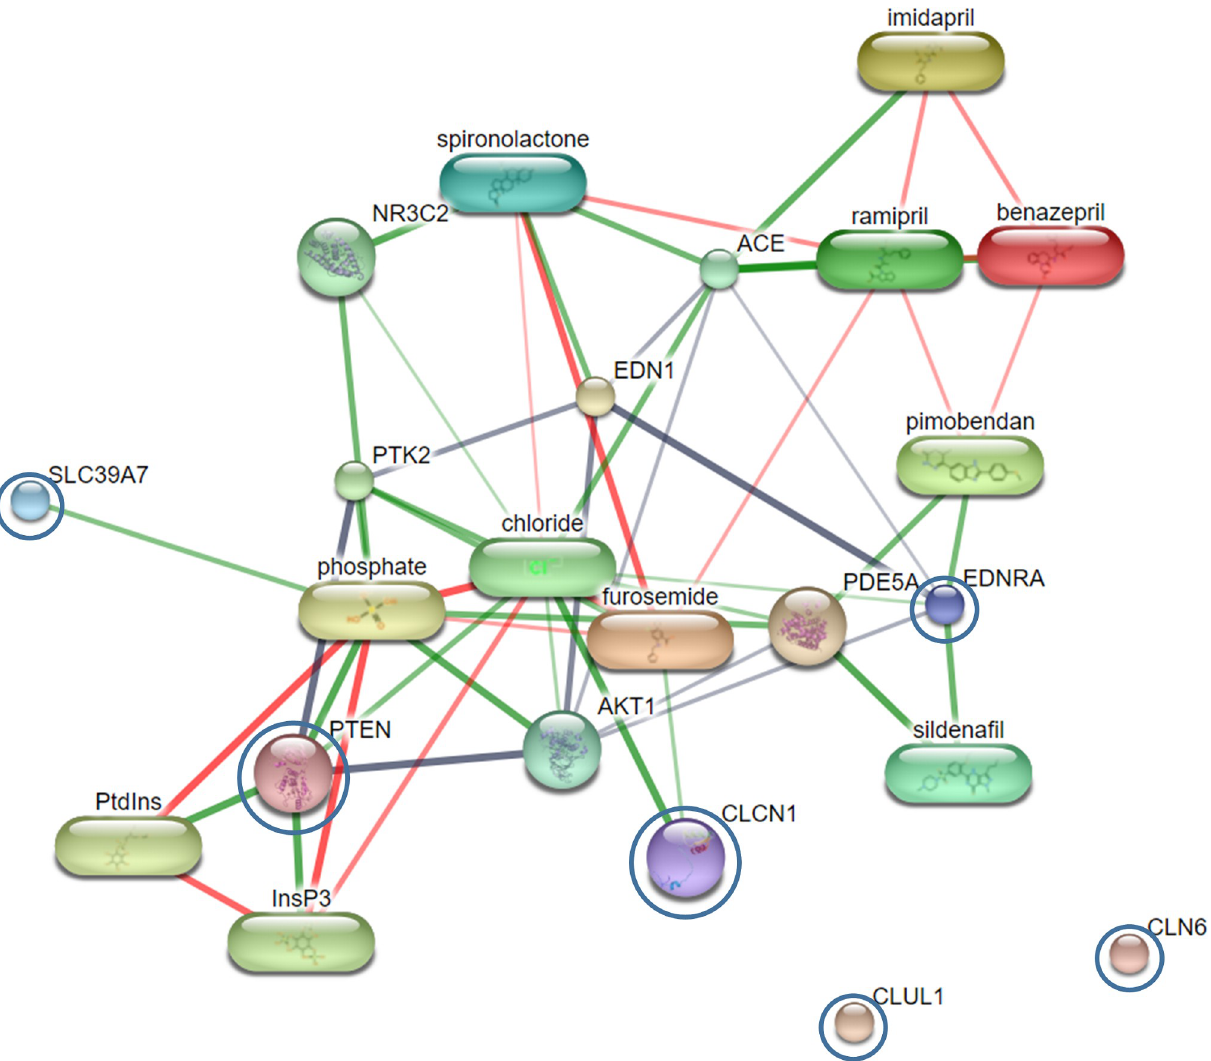
Fig 4. Relationships of CLCN1, EDNRA, PTEN, SLC39A7, CLUL1 and CLN6 proteins (blue circles) in the network of protein-cardiovascular drug interactions. Abbreviations: ACE, angiotensin-converting enzyme; AKT1, v-akt murine thymoma viral oncogene homologue 1; CLCN1, chloride channel protein 1; CLN6, ceroid-lipofuscinosis neuronal protein 6 homologue; CLUL1, clusterin-like protein 1 precursor; EDN-1, endothelin-1; EDNRA, endothelin-1 receptor precursor; InsP3, intracellular messenger formed by the action of phospholipase C on phosphatidylinositol 4,5-bisphosphate; PDE5A, phosphodiesterase 5; PtdIns, phosphatidic acid combined with inositol; PTEN, phosphatidylinositol-3,4,5-trisphosphate 3-phosphatase and dual-specificity protein phosphatase; PTK2, protein tyrosine kinase 2; SLC39A7, zinc transporter SLC39A7.